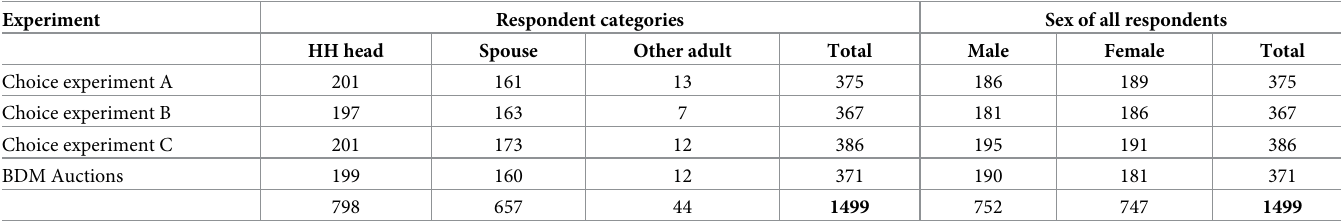
Table 2. Distribution of respondents across experiment